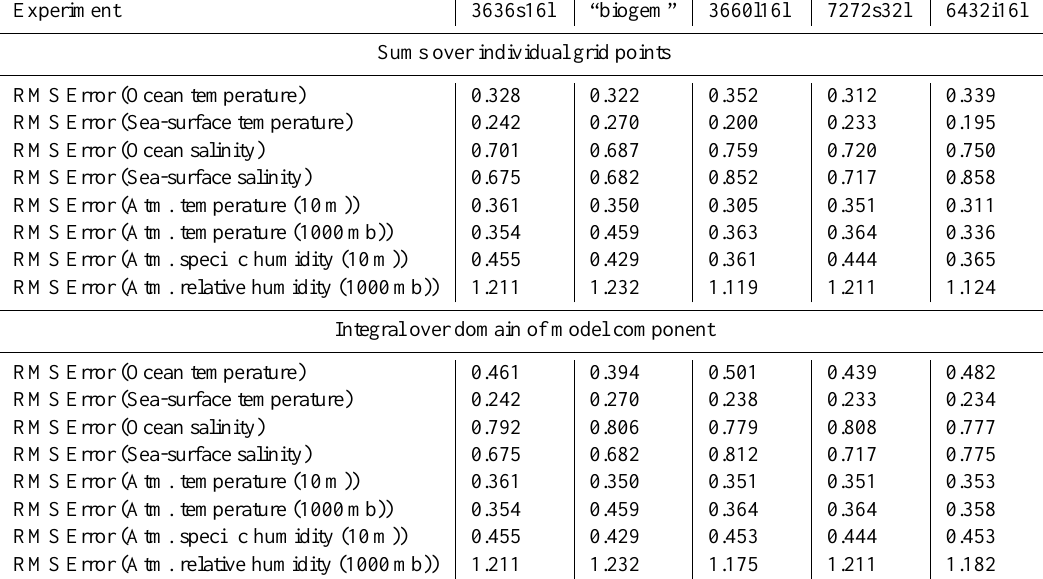
Table 5. Weighted and unweighted root mean square errors, for the atmosphere and ocean, for each experiment. Annual-mean observations are gridded onto each mesh (see Table 1 and Sect. 3.6 for the sources of the datasets and further details). The computation of the sums over individual grid points follows the method of EM05, the integrals over the respective model domain additionally weights the individual grid points according to the volume or area of the corresponding grid box or cell. Note that an error value of 1 would be achieved by hypothetical model output of a uniform field with the same average value as the data-based